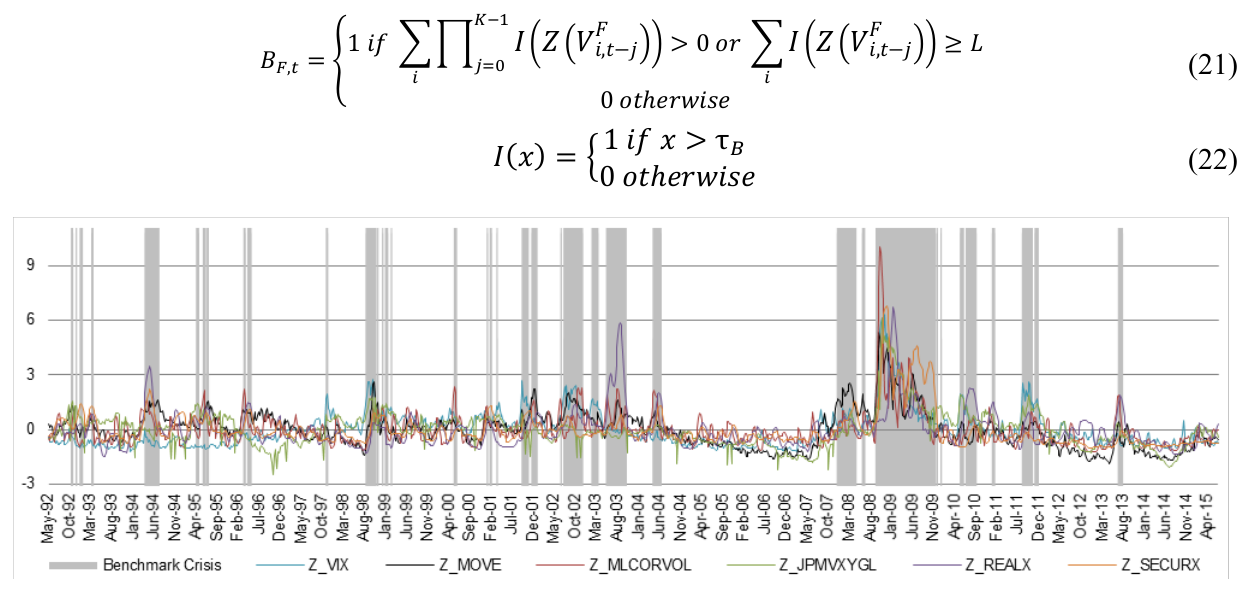
Figure 1. Standardized volatility series and the resulting crisis